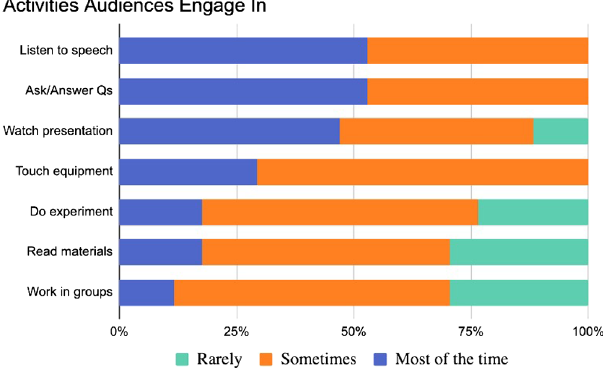
FIG. 7. Different activities that the audience participates in during informal physics